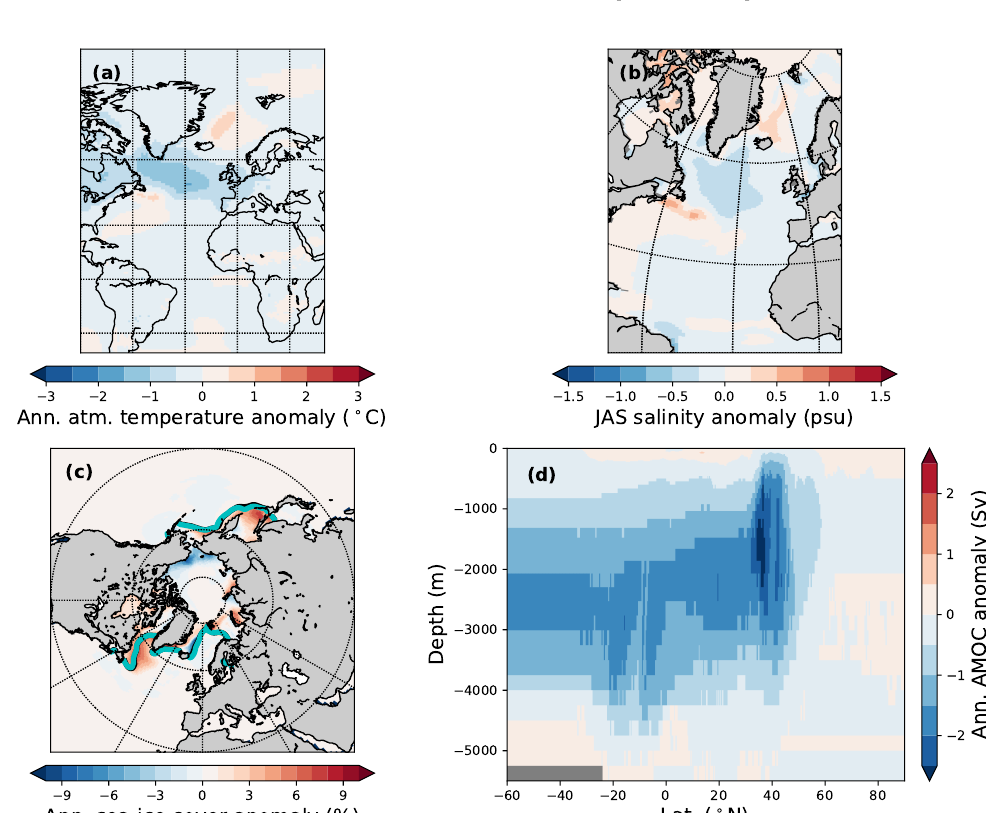
Figure 12. Same as Fig. 10 with the CCSM4 model pool. For clarity, only the contours of the March sea-ice extent are shown. Note the different limits on the colors compared to Fig.